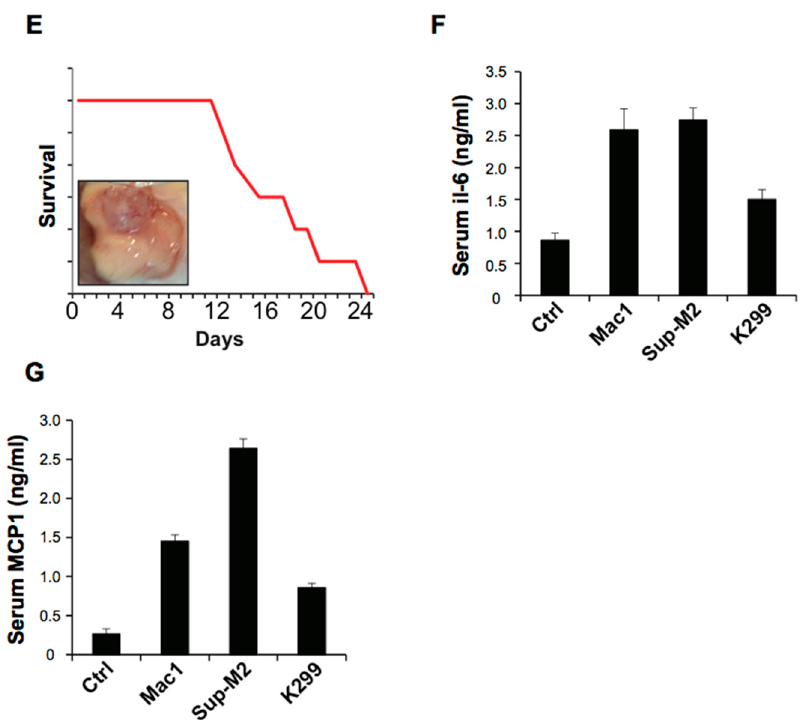
Figure 3. Effects of ALK+ ALCL-derived exosomes on the bone-marrow-derived fibroblasts and cytokine profile: ( A , B ) L88 cells were educated with 60 µ g/mL of SUPM2-derived and DiR-labelled exosomes at the indicated time points. The positive population was quantified by flow cytometry ( A ) and depicted by confocal microscopy ( B ) after 6 h of uptake; ( C ) Morphological changes of bone marrow-derived L88 fibroblasts due to education with SUPM2-derived exosomes (60 µ g/mL) for 60 h. Incubation of the L88 cells with ALCL-derived exosomes also confers molecular changes such as expression of aSMA in the fibroblasts characteristic of the transformation to a cancer-associated fibroblast (CAF) phenotype; ( D ) The cells’ supernatant was recovered and used for the cytokine array assay as described in Materials and Methods. The cytokine expression was captured on X-ray films (left panel) and the differences were visualized by bar charts after normalization (white bars for PBS/control and black bars for SUP-M2 exosomes). ( E ) 10 7 cells from two ALK+ ALCL cell lines, Karpas 299 and SUPM2, and one ALK- ALCL cell line, Mac1, were injected subcutaneously in SCID/beige mice (10 mice for each cell line) and were followed for tumor development.